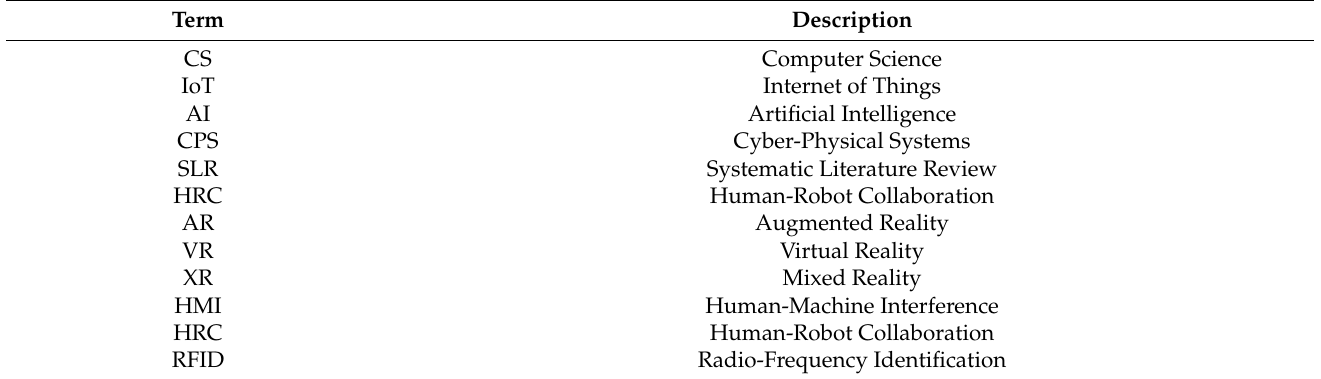
Table A2. Table of Terms sorted in sequence of occurrence in